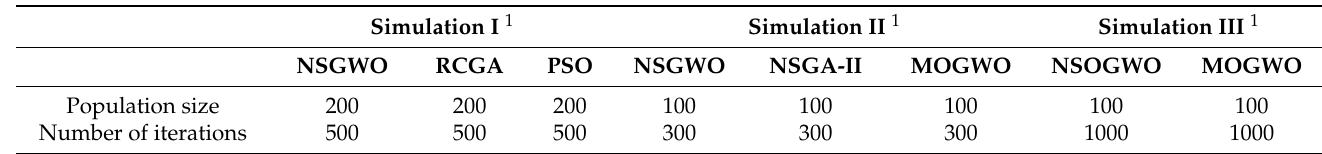
Table 4. Configurations of NSGWO and other intelligent algorithms used in simulations of multiob- jective optimization.